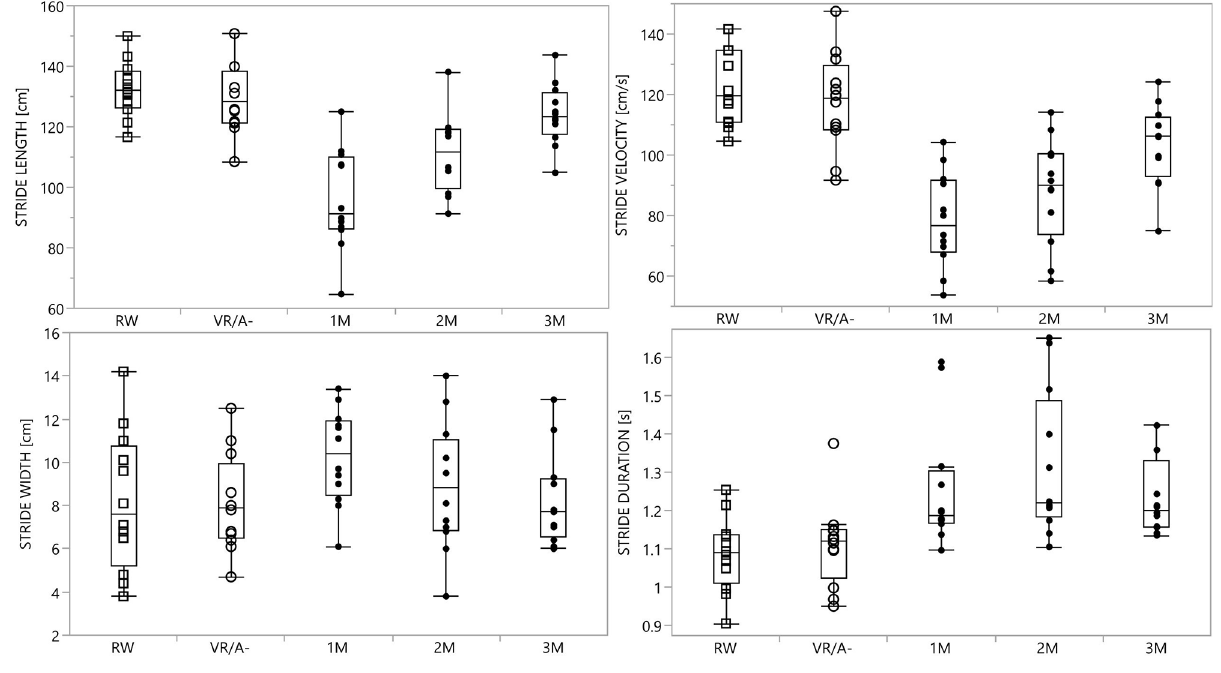
FIGURE 3 | Kinematic measurements of the stride. Graphical representation of kinematic measurements of the stride in all conditions; please see Table 2 for kinematic values and statistics. Data are shown as the mean and standard error of the mean. Abbreviations: RW, real world; VR/A-, virtual reality environment without virtual agent; M1, first modulator; M2, second modulator; M3, third modulator.